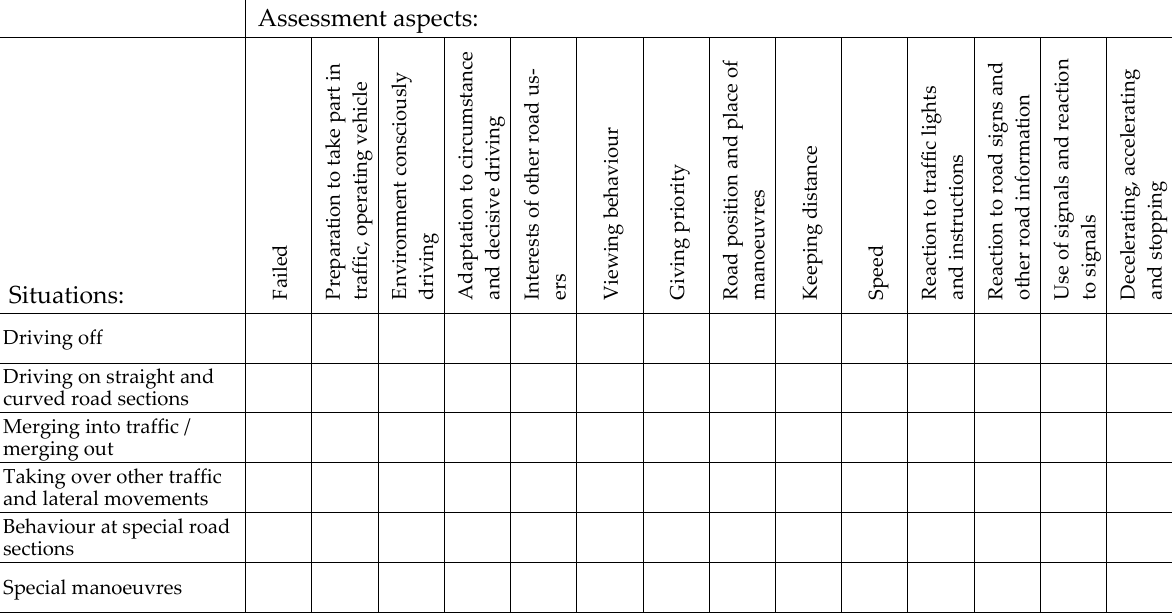
Figure 1. Assessment matrix for driving examination from the Dutch driving licensing agency CBR. Translated from Dutch. Reproduced from [55], CBR: